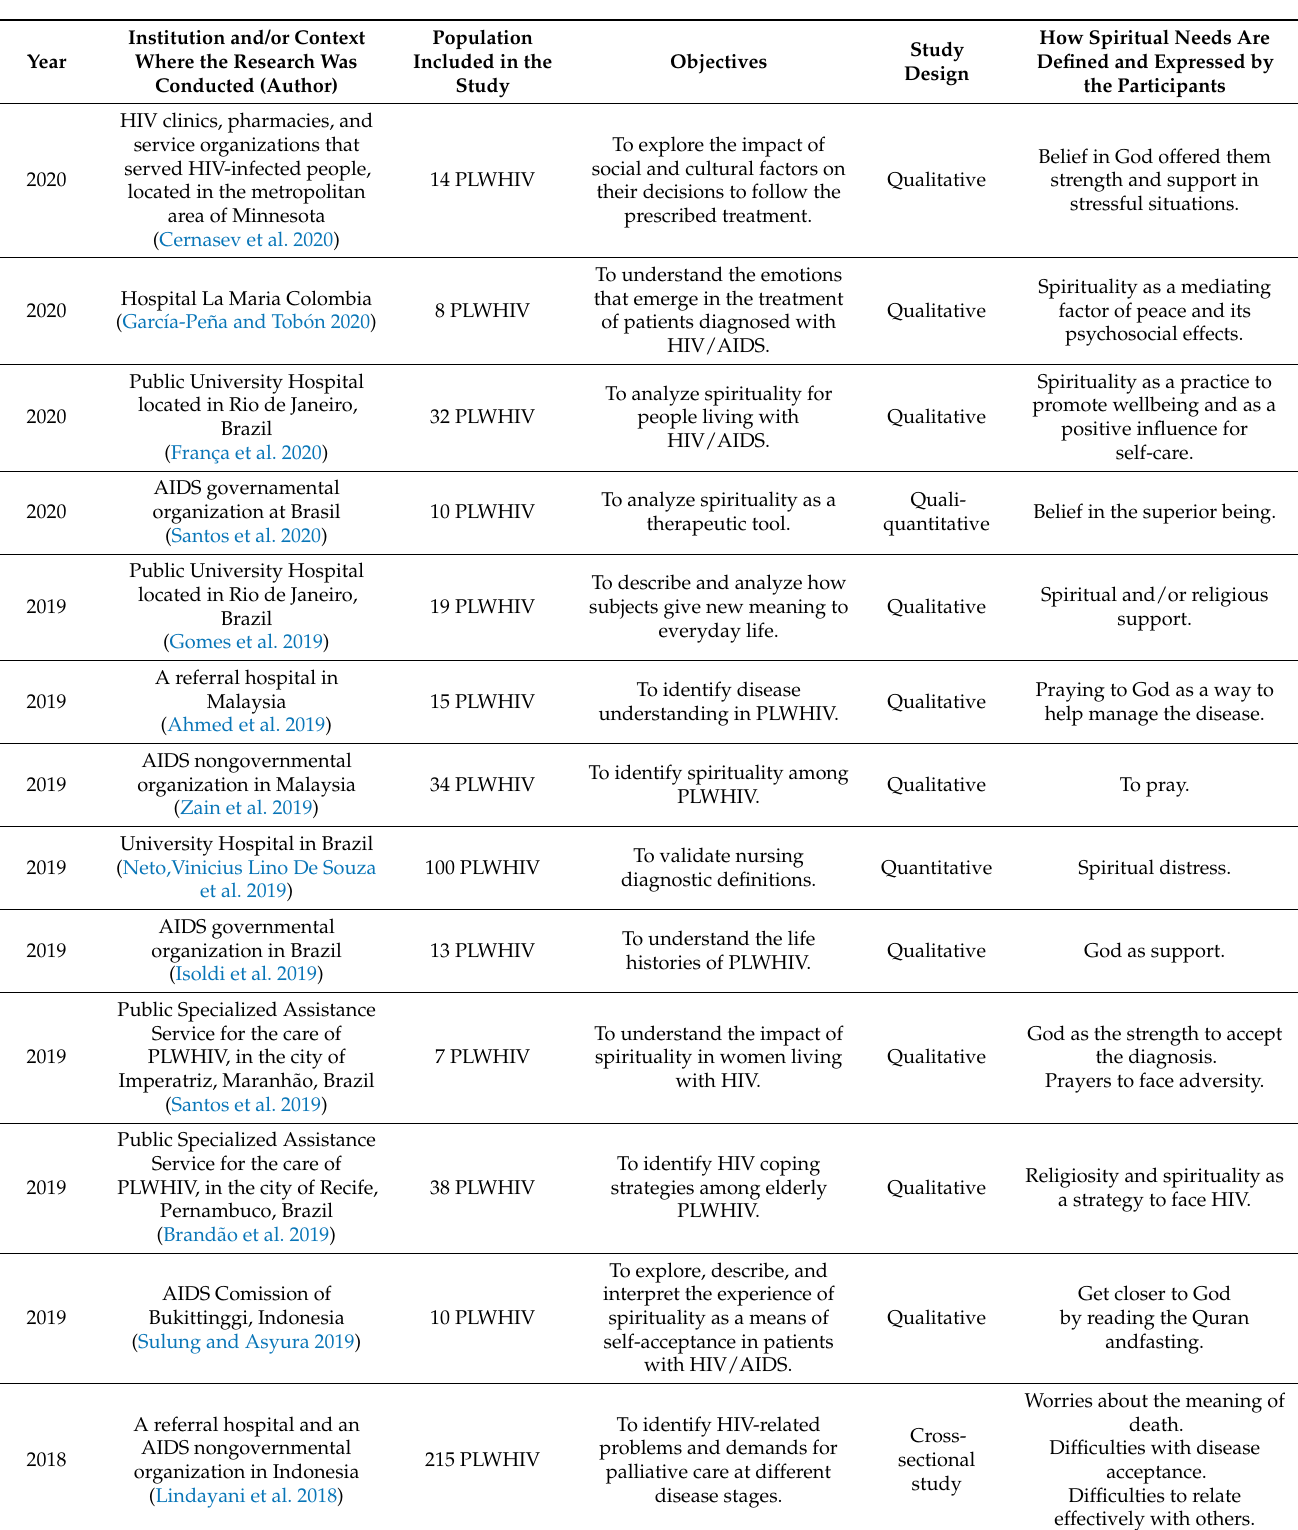
Table 1. Systematic review of studies, concerning the spiritual needs of PLWHIV, published